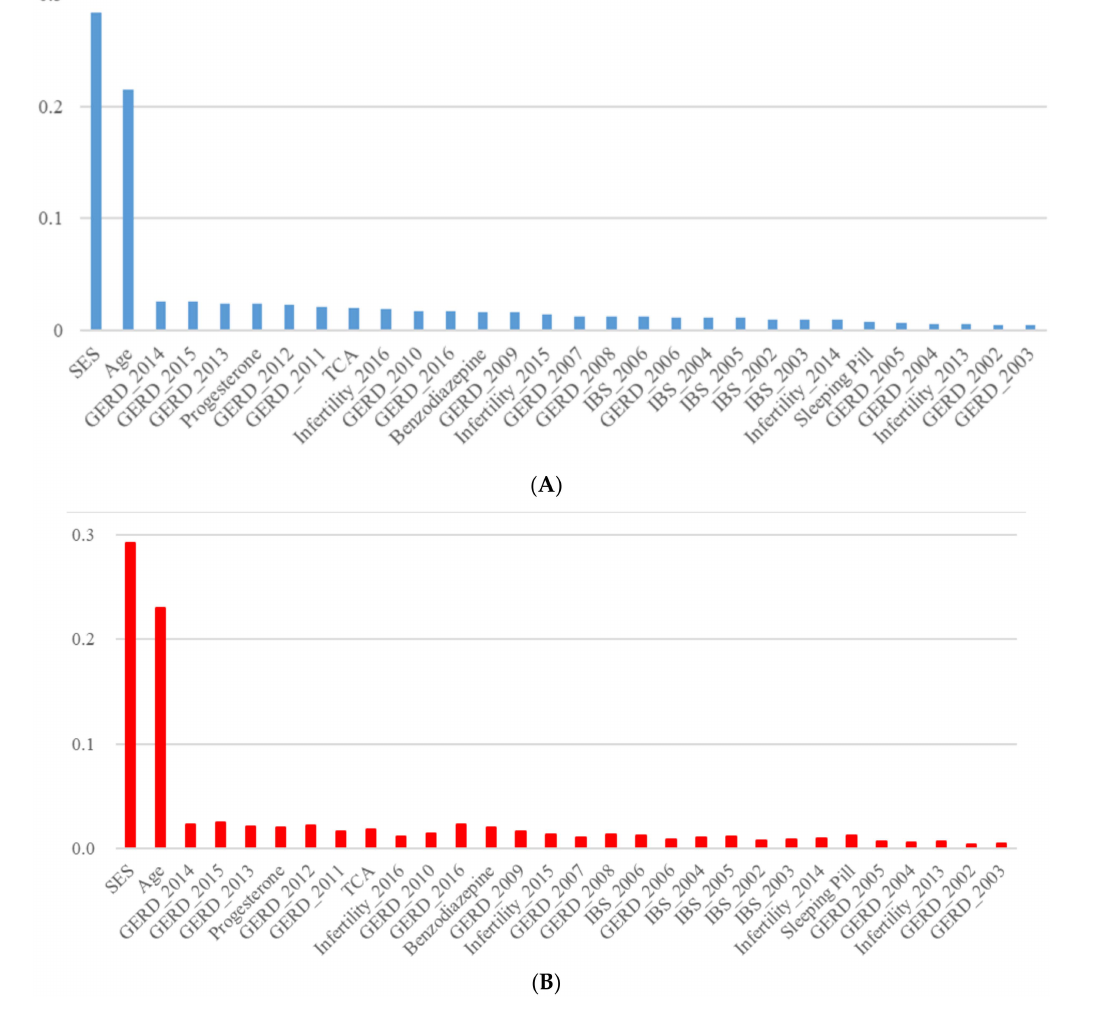
Figure 1. Random forest variable importance-oversampling vs. no sampling for PTB4. ( A ) Oversam- pling ( B ) No Sampling. Based on random forest variable importance with oversampling data in ( A